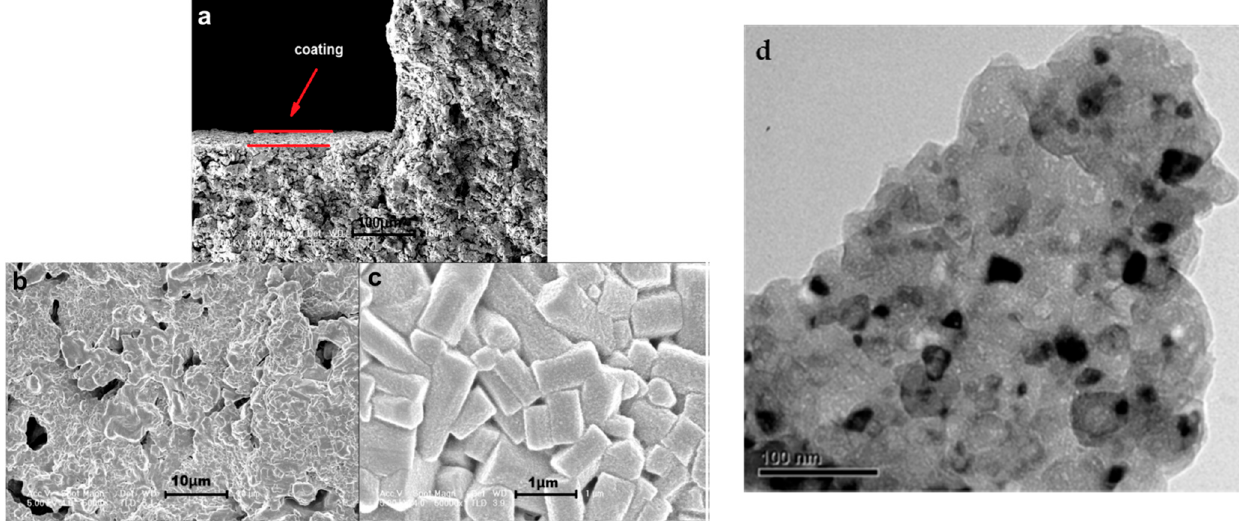
Figure 9. SEM images of the MgAl 2 O 4 coating on the honeycomb cordierite ceramics: cross-sectional view ( a ), surface view ( b , c ), and TEM image of the MgAl 2 O 4 coating ( d ) (reproduced from [170] with permission from Elsevier).